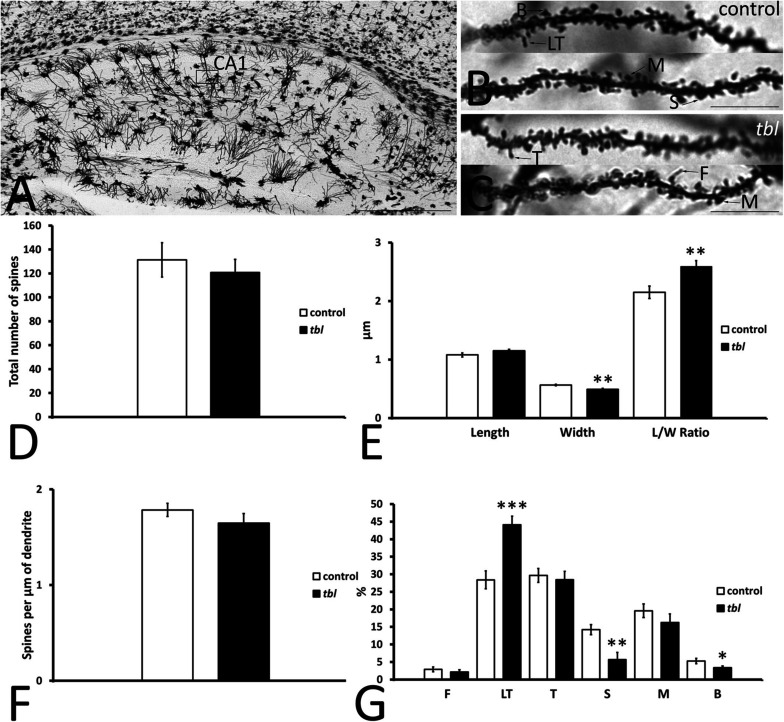
Microphotographs of parasagittal sections through a Golgi-Cox impregnated hippocampus (A–C). (B–C) Illustrate the fully filled dendritic segments used to count and categorize the spines. (D–G) Graphical representations of the number of spines counted (D), the differences in spine length (E), spine width (E), the spine length/width ratio (E, L/W Ratio) and in the density of spines (F) in the CA1 of control and tbl mice. The proportions of the dendritic spine types counted are also shown (G). The smaller width of the spines and the higher length/wide ratio indicate the mainly immature spines in the tbl CA1. The most mature spines, mushroom spines (G, M) seem to be less abundant in the tbl CA1, although these values are not statistically significant, whereas a significant decrease in the number of mature stubby and branched spines is evident in the tbl mice (G, S and B). In addition, there is a significant increase in the number of immature thin long spines (G, LT) in the tbl CA1. The asterisks indicate significant differences in the Student’s t-test: **p = 0.002978 (E, width); **p = 0.005185 (E, L/W ratio); ***p = 0.0003845 (G, LT); **p = 0.002825 (G, S); *p = 0.0290842 (G, B). CA1, cornu ammonis 1; F, filopodia; LT, long thin spines; T, thin spines; M, mushroom spines; S, stubby spines; B, branched spines. Bars = 2mm (A), and 10 μm (B,C).